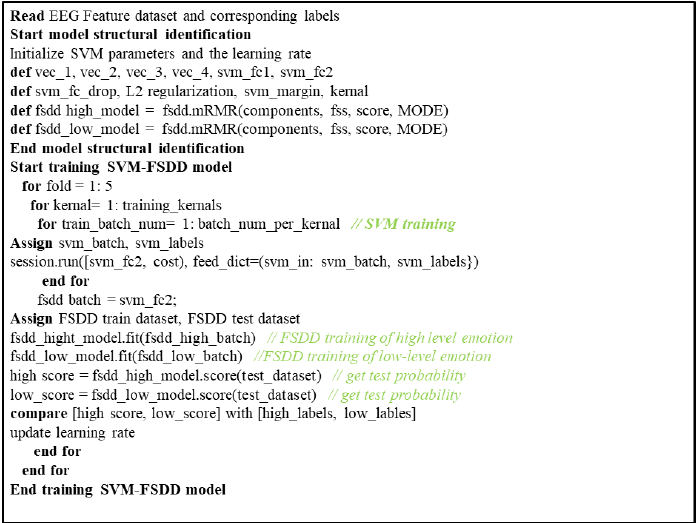
Figure 5. Pseudo code of the detailed procedures for EEG emotion recognition.